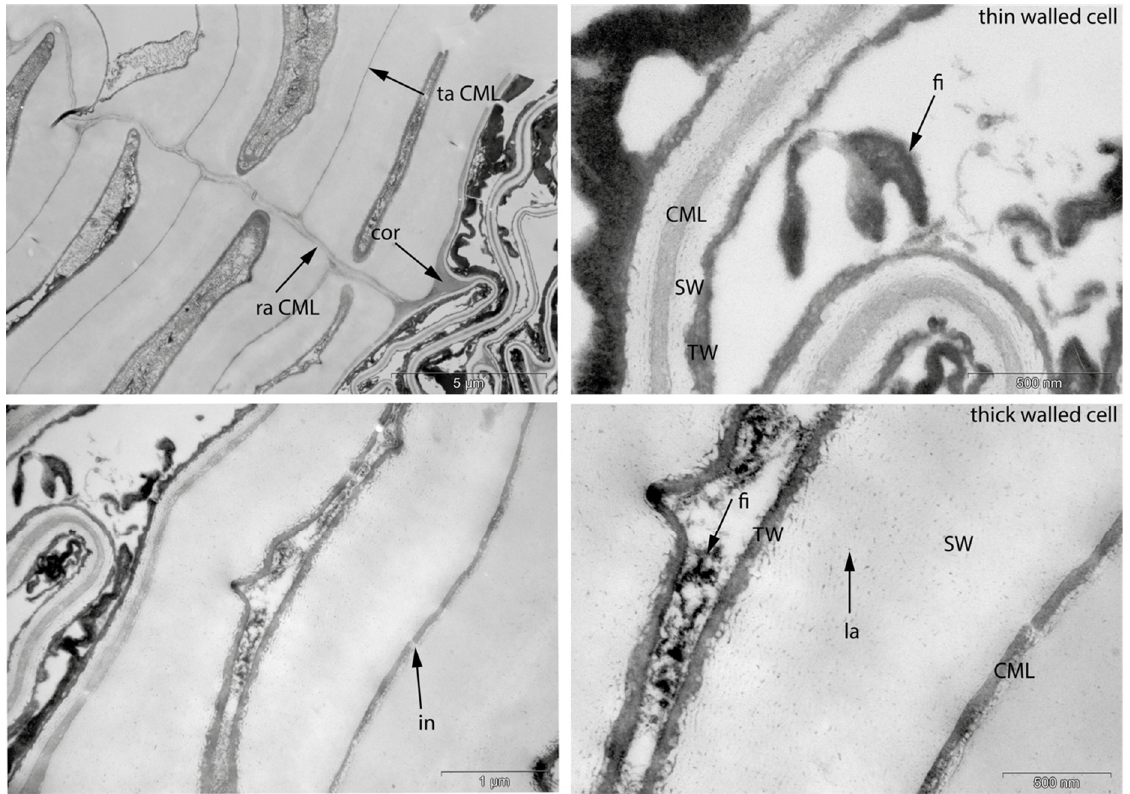
Figure 9. Reference sample. TEM images of thick-walled and thin-walled cells. The compound middle lamella (CML) is thicker in radial direction (ra) than tangential direction (ta) in thick-walled cell bands (top left). In tangential direction, interruptions of composite middle lamella are present (in, bottom left). There is a clearly pronounced corner (cor) at the transition between thick- and thin-walled bands. Details of thin-walled cell (upper right) and thick-walled cell (bottom right) are presented. SW, secondary wall; TW, tertiary wall; la, lamella of secondary suberized cell wall; fi, filling material.